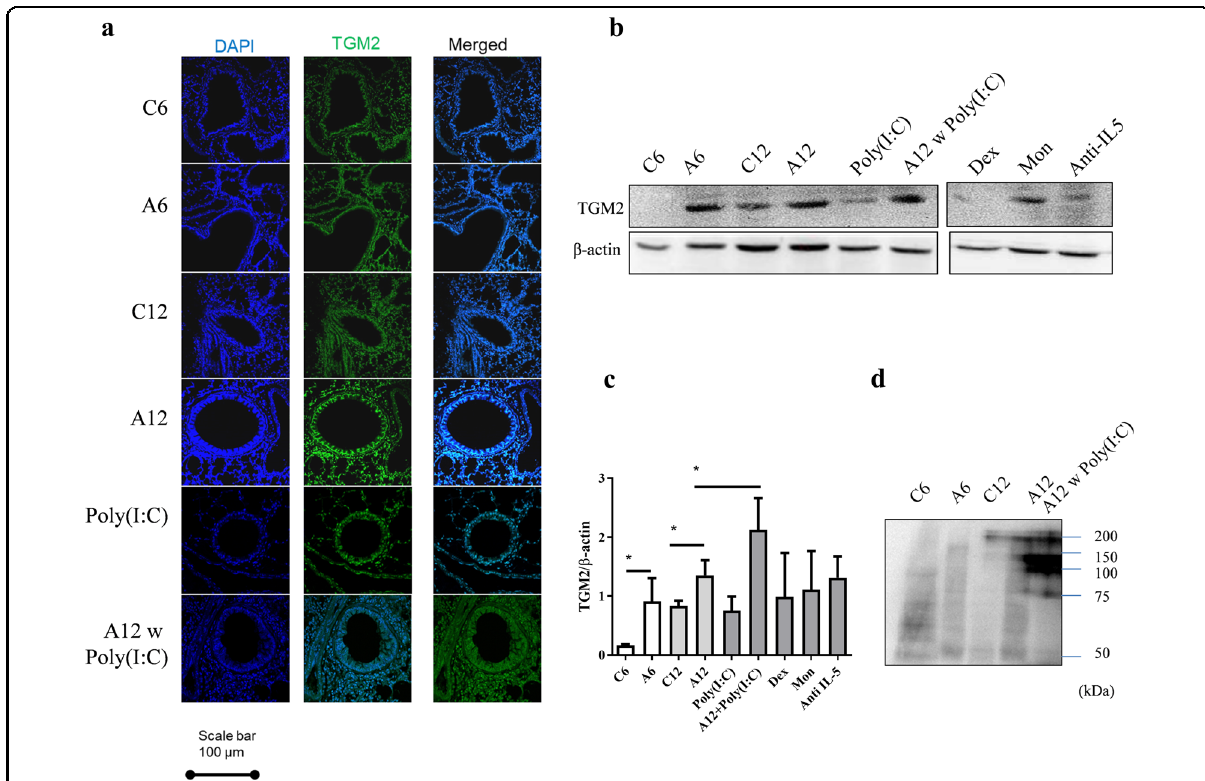
Fig. 5 Increase in polymerized OPN and TGM2 expression with age and viral infection. The expression of TGM2 in the lung tissues of mice were analyzed using a immunohistochemistry and b & c Western blotting. d Increased polymerized OPN in mouse BALF as analyzed by Western blotting. * P < 0.05 compared between the indicated groups. Da daltons; OPN osteopontin; TGM2 tissue transglutaminase